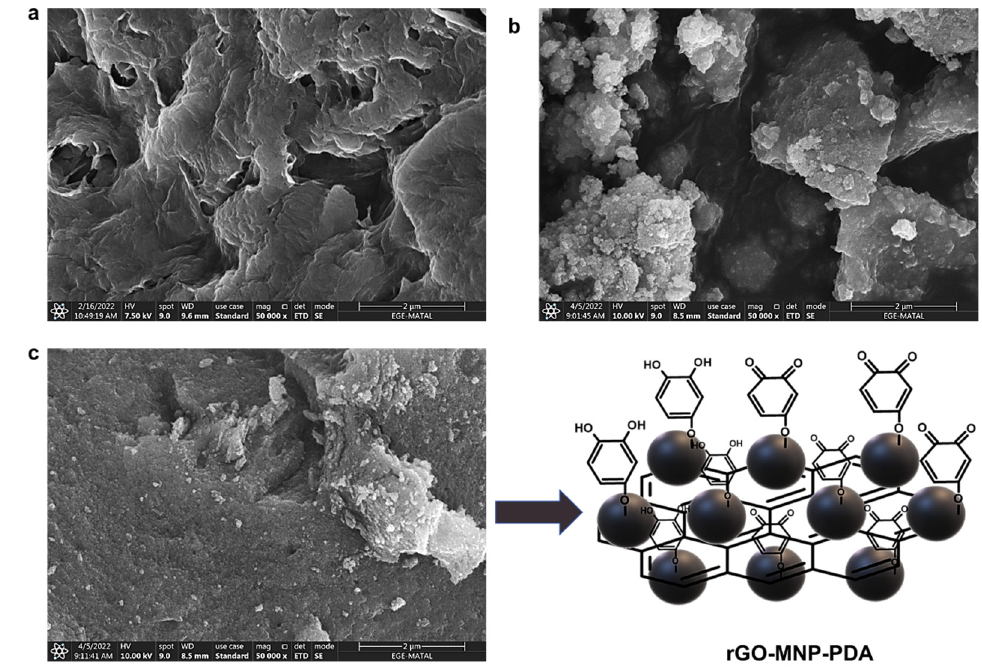
Figure 2. SEM images (50.000 × magnification) of ( a ) GO, ( b ) rGO-MNP, and ( c )